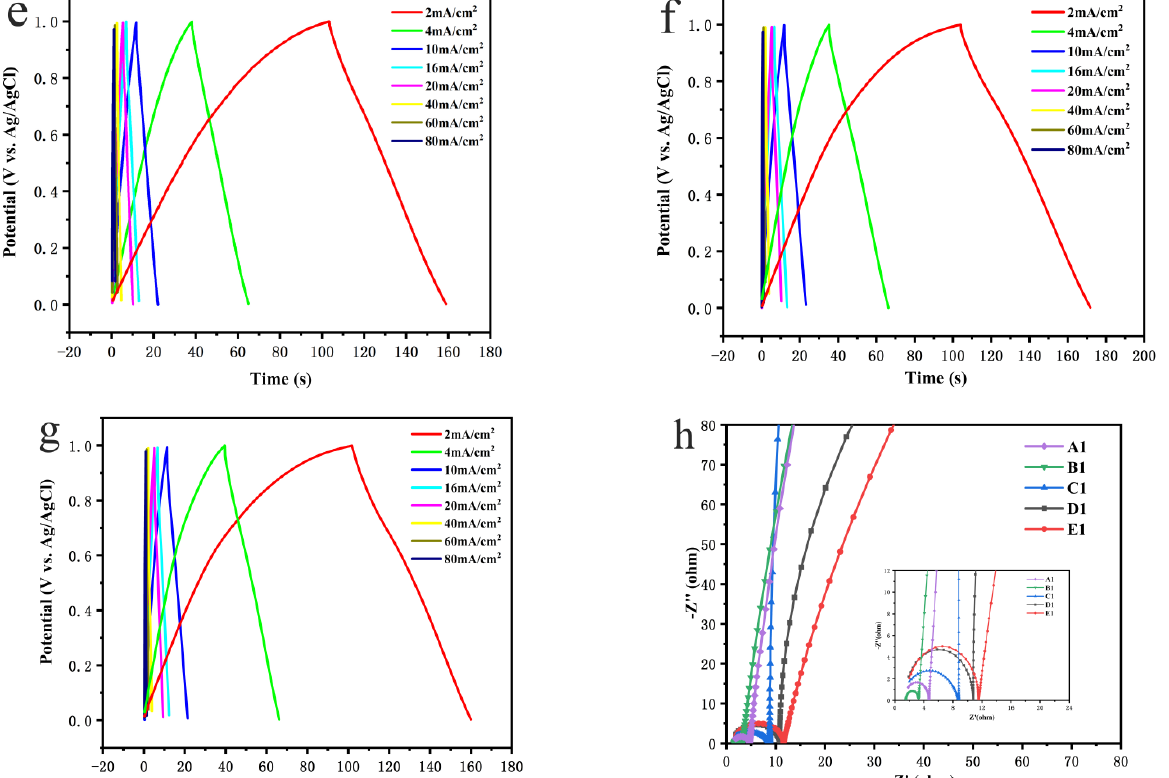
Figure 8. CV curves of the A1 ( a ), B1 ( b ) and C1 ( c ) electrodes for scanning rates of 5–100 mV s − 1 ; area specific capacity ( d ) of the A1, B1 and C1 (0.01 < p < 0.05, *, p < 0.01, **); GCD curves of the A1 ( e ), B1 ( f ) and C1 ( g ) electrodes for current densities of 2–80 mA cm − 2 ; Nyquist plots ( h ). Note: MWCNTs and CNF are dispersed in deionized water at mass ratios of 1:0.4, 1:0.7 and 1:2, as electrodes A1, B1 and C1. MWCNTs and chitosan are dispersed in deionized water at a mass ratio of 1:0.7 and recorded it as electrode D1. MWCNTs are dispersed in deionized water as electrode E1 and the pure foam nickel after pretreatment is referred to as F1.